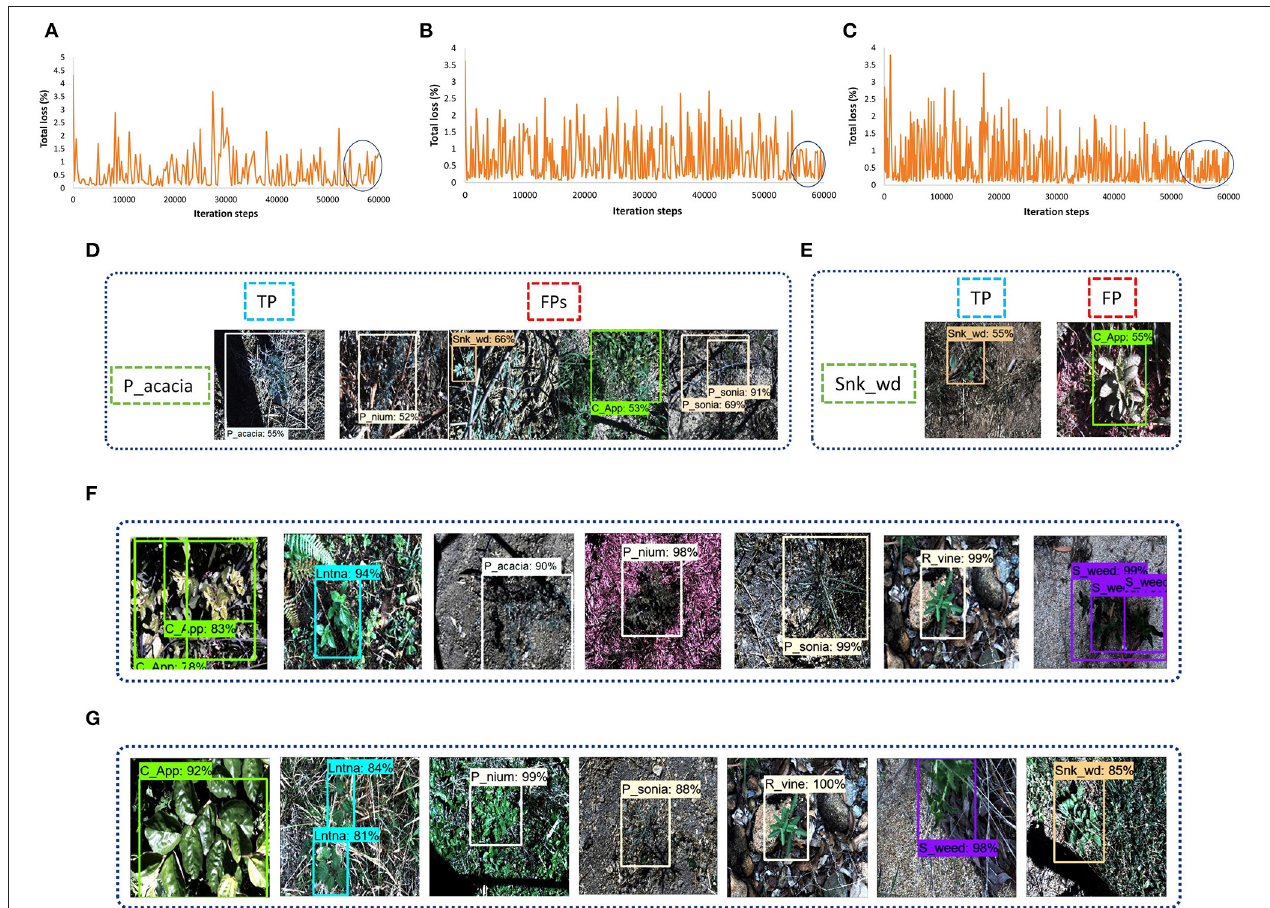
FIGURE 9 | Faster Region-base fully convolutional neural network (RCNN) performance with various versions of DL models: (A) total loss plot for Inception-v2: (B) total loss plot for ResNet-50; (C) total loss plot for ResNet-101; (D) false positives of prickly acacia with Inception-v2; (E) false positives of snake weed classes with Inception-v2; (F) true positives with ResNet-50; (G) true positives with ResNet-101.